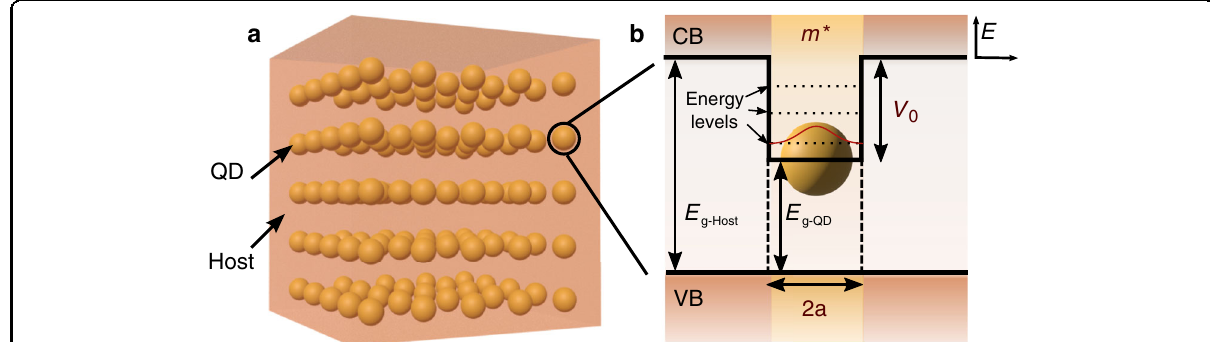
Fig. 1 3D sketch and energy level diagram of nanostructured (dots-in-host) semiconductor. a Representation of an array of colloidal QDs, with radius a and effective mass m *, embedded in a host material (e.g., PbS QDs in a Perovskite host, as analyzed in this work). b Energy band diagram for the system in ( a ), where CB and VB represent, respectively, the conduction and valence band of the host, and V 0 is the potential barrier given by the difference between the bandgaps of the host ( E G-Host ) and QD ( E G-QD ) materials. On the top right corner, we show the coordinate system used, in which the zero energy is set at the CB minimum